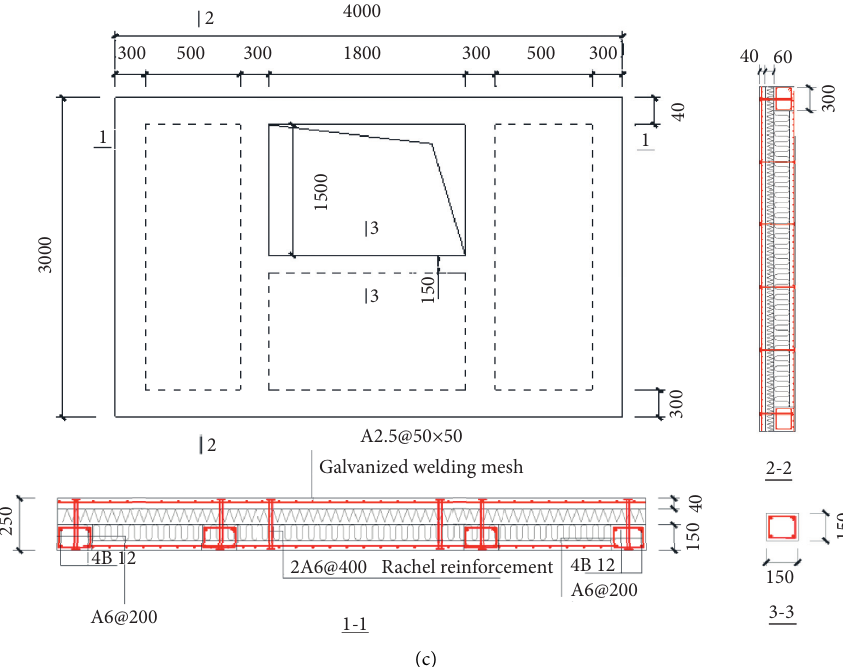
Figure 1: The structure of the RHRC Sandwich wall: (a) the composition of the wall; specimen size and reinforcement of the wall (b) without a hole and (c) with a hole.